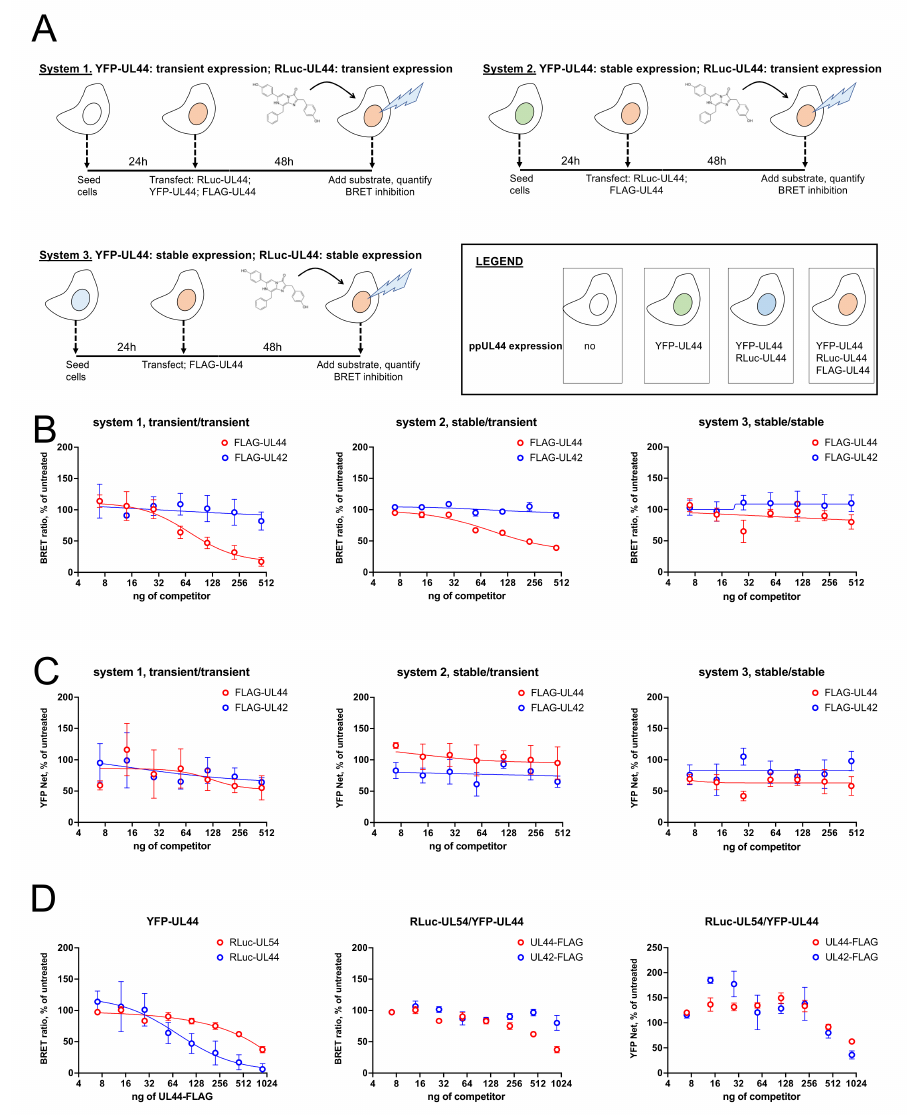
Figure 7. Stable expression of RLuc-UL44 and RLuc-UL54 allows to detect a concentration-dependent decrease in BRET ratio upon overexpression with FLAG-UL44. ( A ). The three different expression systems compared for detection of inhibition of BRET signal upon overexpression of a known competitor are shown. After carefully selecting condition to generate similar BRET rations, cells were transfected with increasing amounts of either pDESTnFLAG-UL44 as a competitor or pDESTnFLAG- UL42 (range 0–500 ng) as a control. At 48 h post transfection, cells were subjected to fluorometric and luminescence measurements to detect BRET ratios ( B ) and YFP expression ( C ) relative to each condition. Data shown are the mean + relative to at least three independent experiments. HEK293T were also transiently transfected with appropriate amounts of RLuc-UL54 and YFP-UL44 expression plasmids in the presence of increasing concentrations of either pDESTnFLAG-UL44 as a competitor, or pDESTnFLAG-UL42 as a control (range 0–1000 ng). At 48 h post transfection, cells were subjected to fluorometric and luminescence measurements to calculate BRET ratios ( D ; left and middle panels) and YFP expression ( D ; right panels) relative to each condition. A RLuc-UL54/YFP-UL44 inhibition of BRET ratio upon FLAG-UL44 expression is shown as compared to that obtained for RLuc-UL44/YFP- UL44 ( D ; left panel) or for FLAG-UL42 overexpression ( D ; middle panels). Data shown are the mean + relative to at least three independent